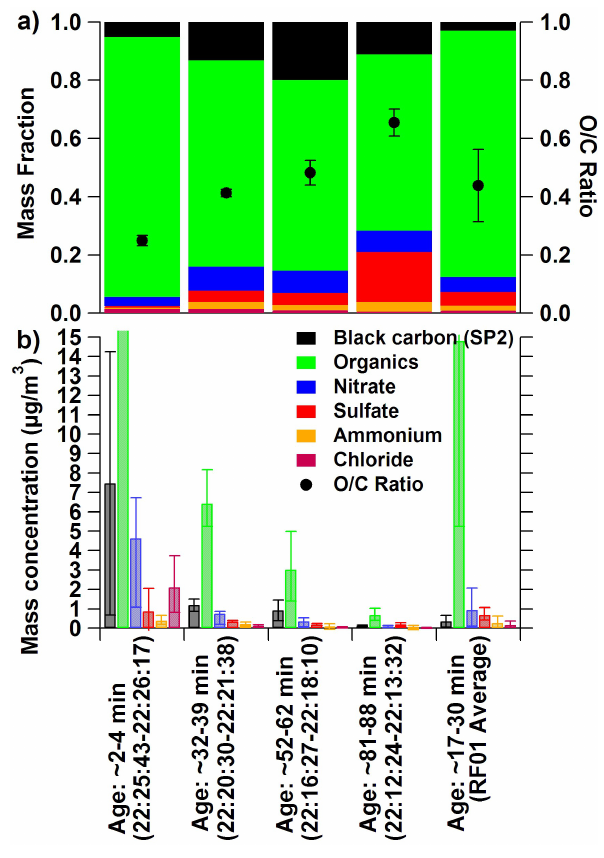
Fig. 3. (a) Submicron aerosol mass fractions considering black carbon, measured by the SP2, as well as non-refractory organics, sulfate, nitrate, ammonium, and chloride, measured by the C-ToF- AMS for the four RF03 plume periods, as well as the RF01 plume average. Uncertainty ranges in the mass fractions are noted in Ta- ble 3. The O/C ratio of the organics, measured by the C-ToF-AMS, is also illustrated. (b) Submicron average species mass concen- trations measured by the SP2 and C-ToF-AMS; note that average organic mass concentrations during Period 1 (age ∼ 2–4min) and RF01 are offscale: 129 [88–195] µgm − 3 and 15 [5–33]µgm − 3 ,